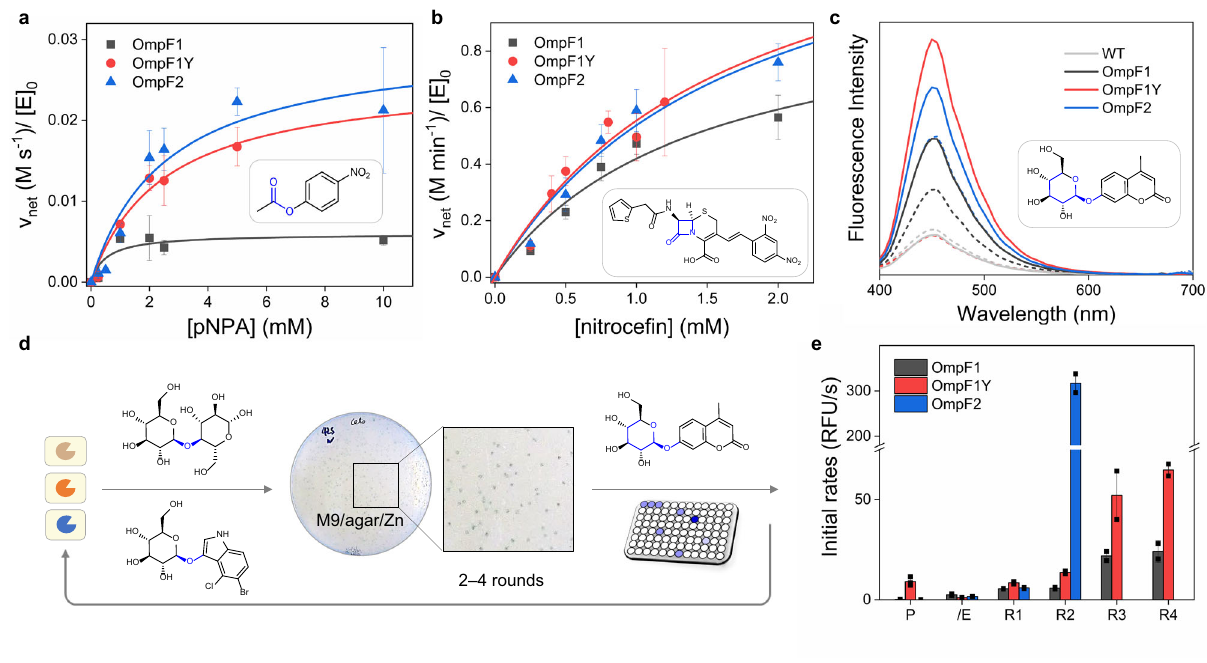
Fig. 3 | Zn-dependent hydrolytic activities. Kinetic analysis with a pNPA and b nitroce fi n. c Fluorescence changes upon the hydrolysis of 4- β -MUG. Solid and dotted lines in c indicate the presence and absence of Zn ions, respectively. d Directed evolution of Zn-dependent β -glucosidase. e Whole-cell activity of the selectedmutantson4- β -MUG,wherePand/Eindicatetheparentproteins(OmpF1,